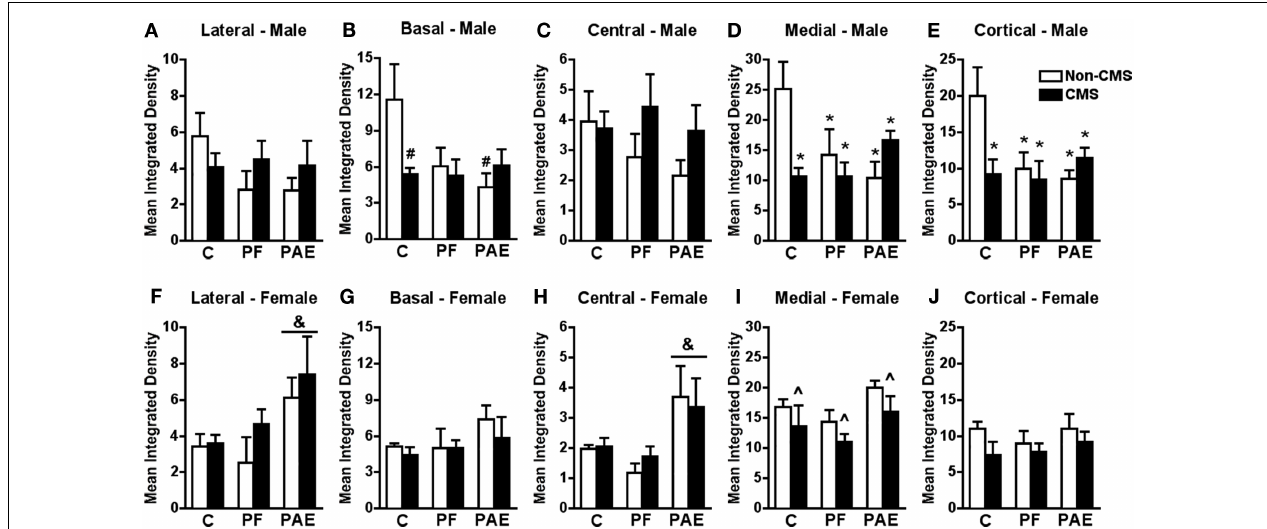
exposure where all groups are different from C non-CMS; & indicates a significant main effect of prenatal treatment where the post hoc test shows that PAE is different from C and PF, independent of CMS; ∧ indicates a significant main effect of CMS exposure where all animals exposed to CMS are different from animals not exposed to CMS; # indicates that control CMS and PAE non-CMS are different from control non-CMS based on a priori comparisons ( n = 4–5 for all